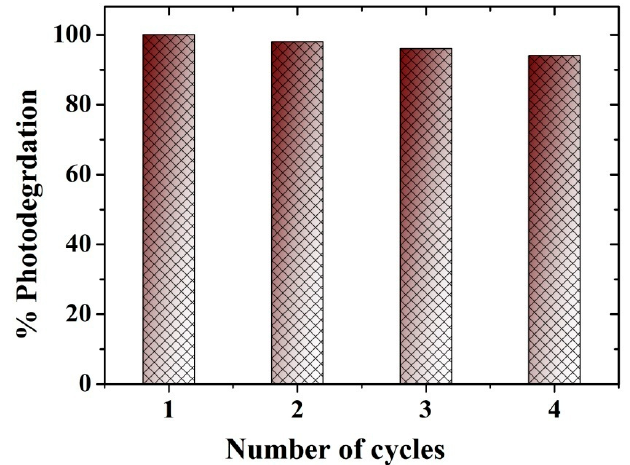
Figure 9. Recyclability of photocatalyst 3B-TiO 2 -CNT nanocomposites.